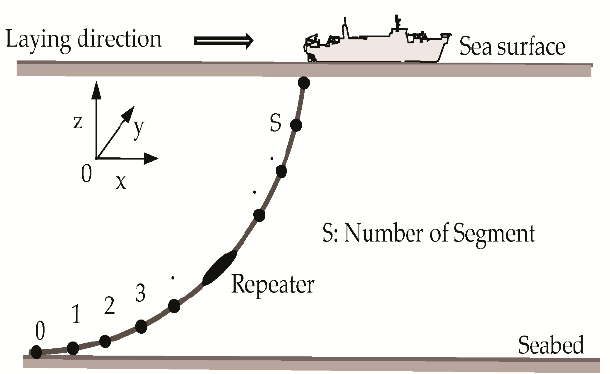
Figure 9. Schematic of cable catenary in the water and its positional relationship with the ship.